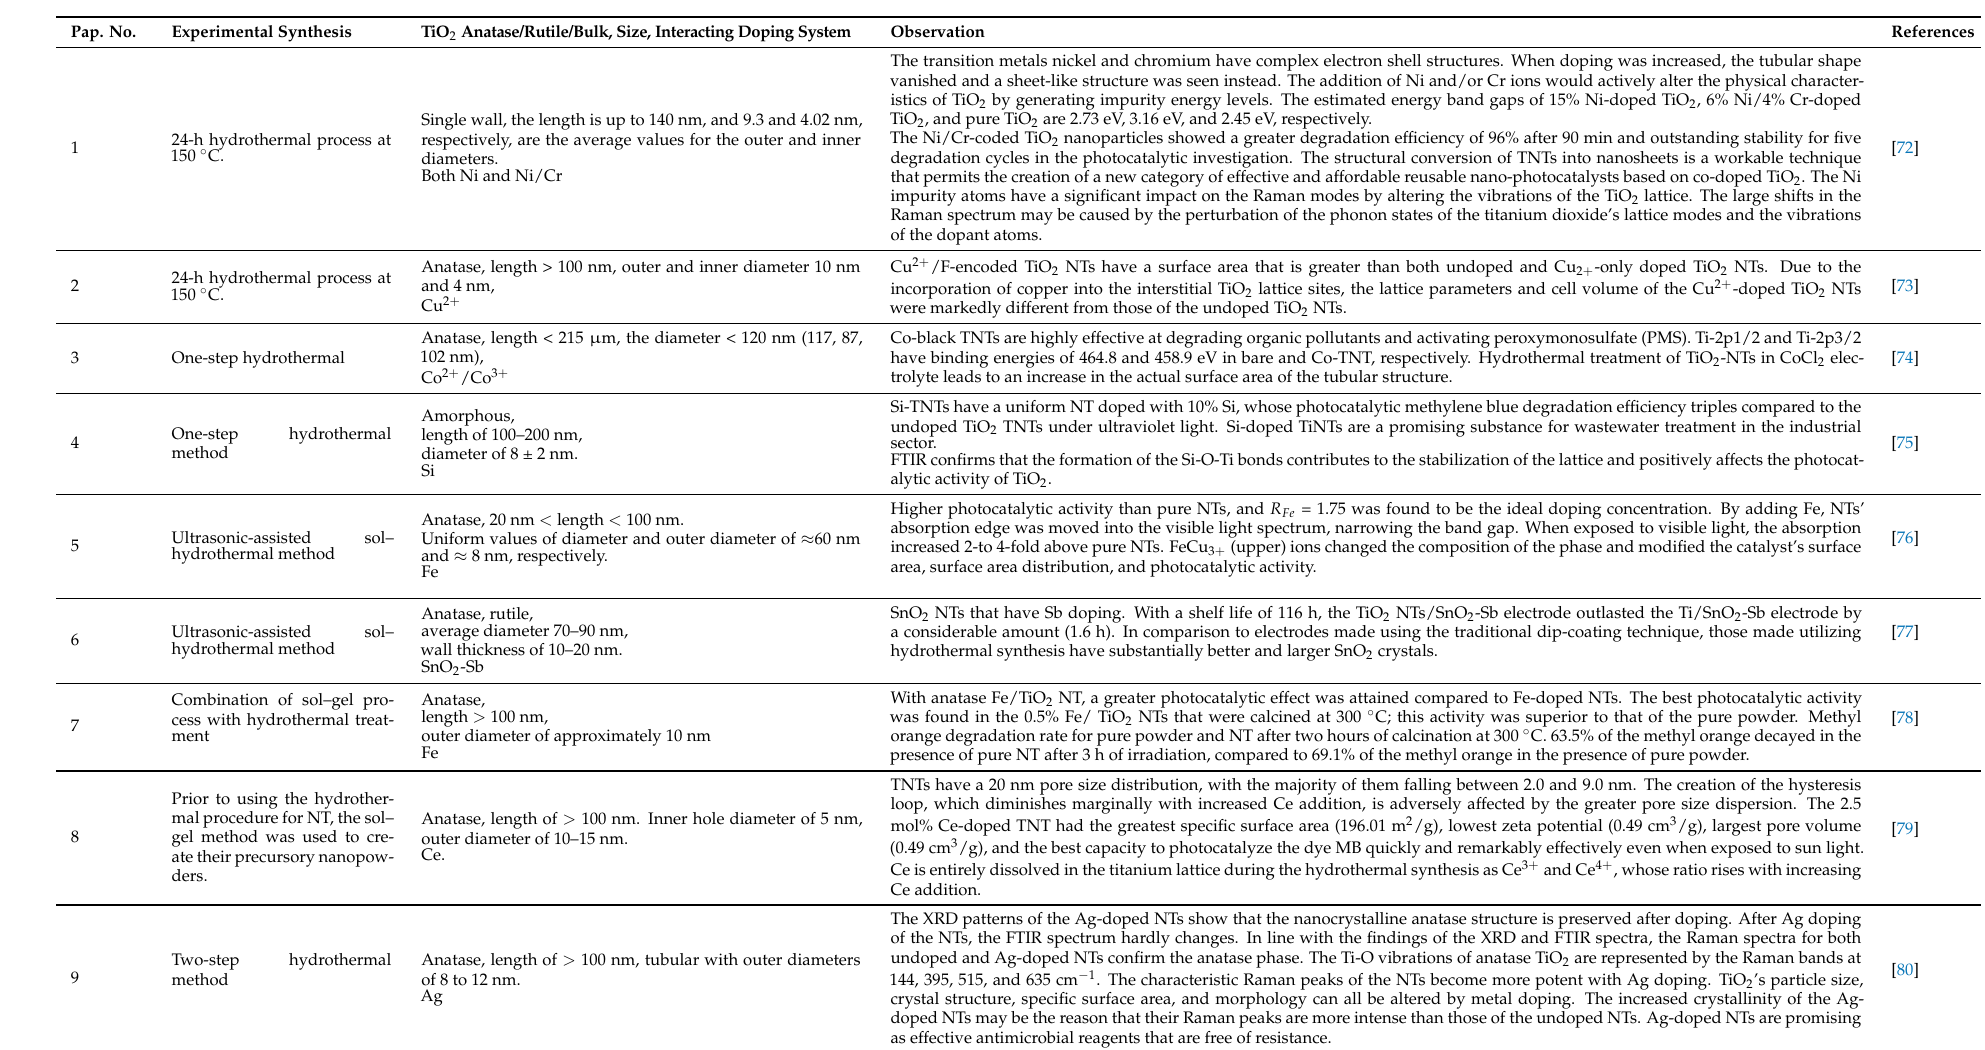
Table 1. Different methods of experimental synthesis, characterization, and their applications in metal doping for TiO 2 nanotubes. Pap.